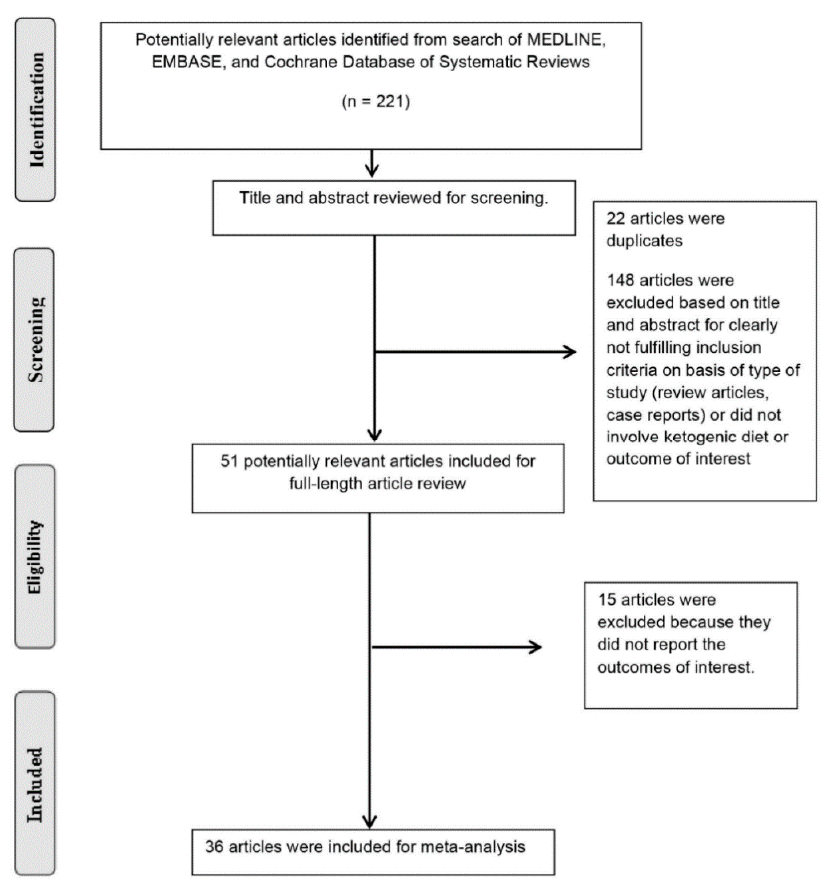
Figure 1. The literature retrieval, review, and selection process.